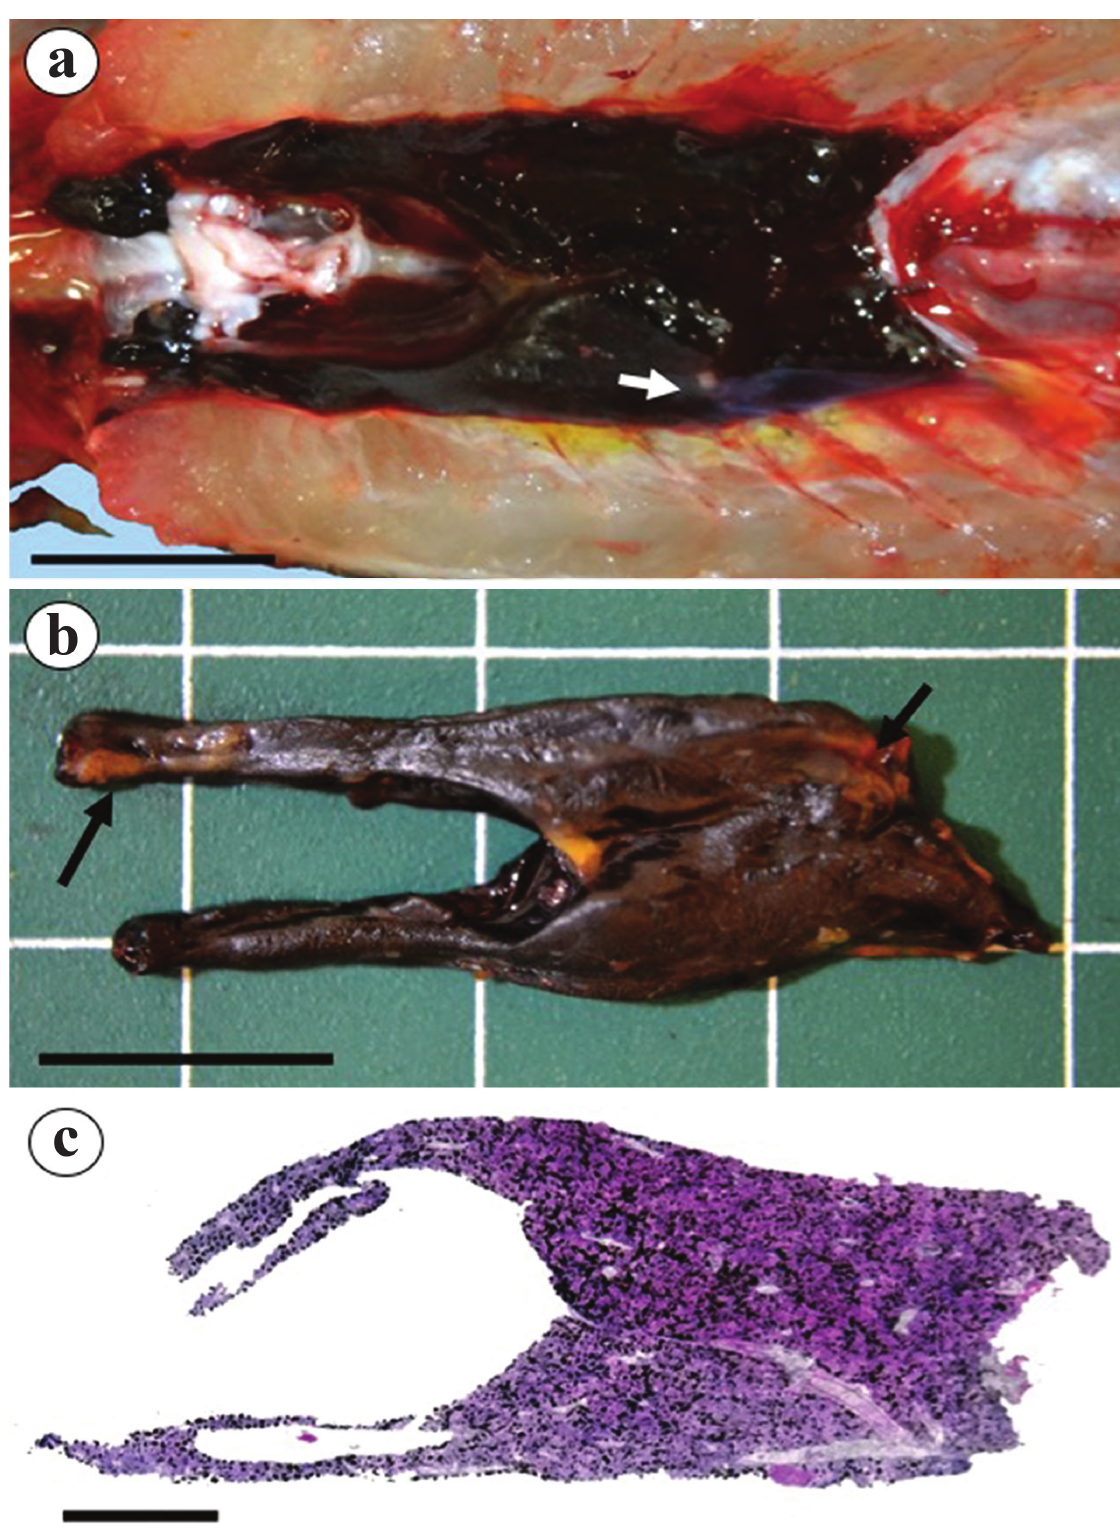
Fig. 1. Macroscopic and submacroscopic aspects of the kidney in Gymnotus inaequilabiatus . a. anatomical position; dorsal to the ventral vertebral column. The branches of the head portion are narrow and separated by healthy connective tissue (white color). The organ was not fixed and shows the natural color ranging from dark brown to black. Note a rounded and whitish lesion (arrow). b. dissected organ post-fixation process. The arterial vessel is positioned on the ventral side (arrows). c. submacroscopic aspect showing the MMCs diffusely distributed in both head and exocrine kidney. Bar scale = 1